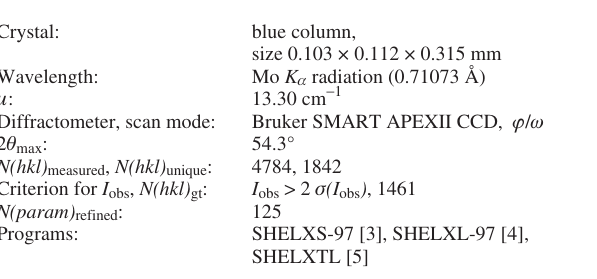
Table 1. Data collection and handling.